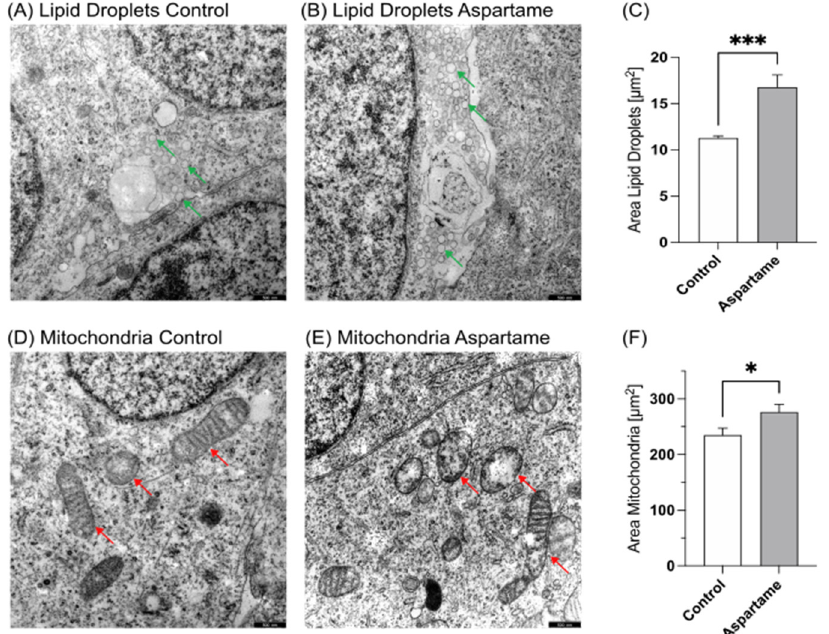
Figure 1. Transmission electron microscopy of SH-SY5Y wild-type cells. ( A ) Control-treated SH-SY5Y cells at 12,000 × magnification. Green arrows mark lipid droplets. ( B ) SH-SY5Y cells treated with aspartame at 12,000 × magnification. Green arrows mark lipid droplets. ( C ) Comparison of the area of lipid droplets in control- and aspartame-treated cells in a bar chart. Error bars represent the standard error of the mean (SEM). The statistical significance was set as *** p ≤ 0.001. ( D ) Control-treated SH-SY5Y cells at 12,000 × magnification. Red arrows show mitochondria. ( E ) SH-SY5Y cells treated with aspartame at 12,000 × magnification. Red arrows show mitochondria. ( F ) Comparison of the area of mitochondria in control- and aspartame-treated cells. Error bars represent the standard error of the mean (SEM). The statistical significance was set as * p ≤ 0.05. Scale bars for ( A , B , D , E ): 500 nm.